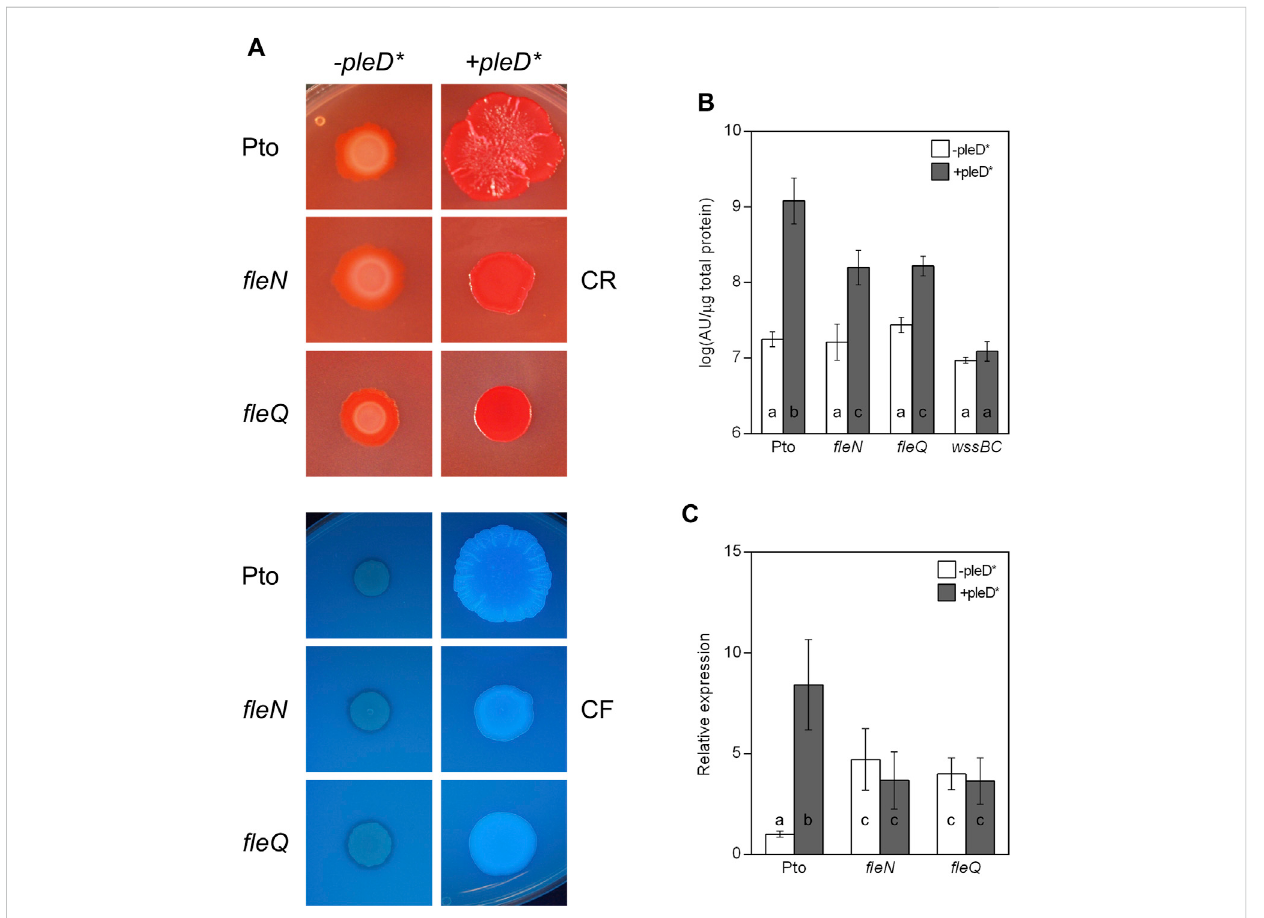
FIGURE 2 Colony morphology and cellulose production in the fl eN mutant. (A) Colony morphology of the fl eN mutant. Representative colony morphology of the different strains grown in agar plates supplemented with Congo Red and Calco fl uor in the presence and in the absence of pleD *. Five μ l of bacterial suspensions at A 660 = 1.0 were placed on the surface of MMR plates with CR (50 μ g/ml, top) or CF (100 μ g/ml, bottom) and pictured after incubation at 20 ° C for 3 days and then at 10 ° C for 5 days. (B) Cellulose production at different c-di-GMP levels. Pto and the fl eN and fl eQ mutants were grown in MMR with CF (100 μ g/ml) for 24 h at 20 ° C, and the fl uorescence emission of the cell attached CF in liquid cultures was measured. The graphs show the average amount of cellulose produced by the indicated strains in the absence (white bars) and in the presence of pleD * (grey bars) as fl uorescence (in arbitrary units) referred to total cell protein. Note that the wssBC mutant does not produce cellulose, therefore the bars indicate non-speci fi c CF retention.Errorbarscorrespondtothestandarddeviationofthreebiologicalreplicatesanda-cdenoteANOVAcategorieswithsigni fi cantdifferences( p < 0.01). (C) Effect of c-di-GMP on the expressionof thewss operon. Total RNAswere obtained from bacteria grown in MMR at 20 ° C for 24 h. Results show qRT-PCR of wssB in the wild type strain (Pto) and fl eN and fl eQ mutants, with pJB3Tc19 (in the absence of pleD* , white bars) or with pJB3pleD* (in the presenceof pleD *,greybars).Expressionvalueswerenormalisedwiththehousekeepinggene gyrA andreferredtothewildtypeconditionintheabsence of pleD *. The graph shows theaverage mRNA levels anderror barscorrespondto thestandarddeviationof four biological replicates; a-c denoteANOVA categories with signi fi cant differences ( p <